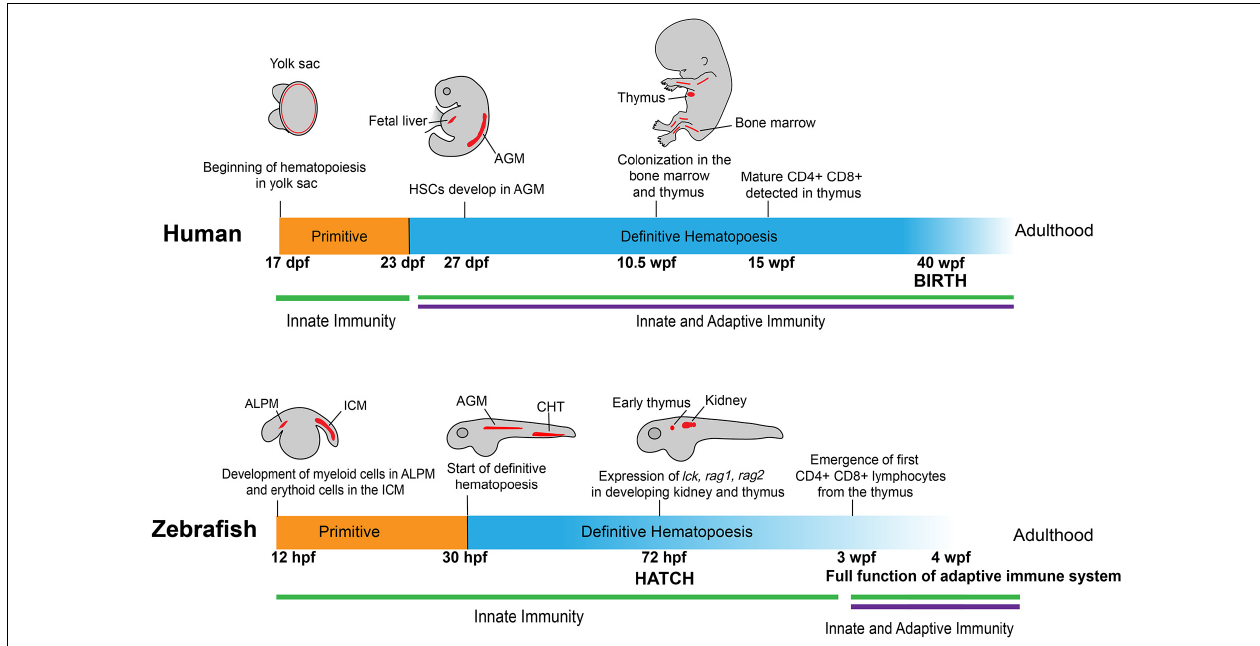
FIGURE 1 | Development of human and zebrafish immune systems. The development of the immune system starts with hematopoiesis at ∼ 17 dpf in humans and 12 hpf in the zebrafish, with myeloid and erythroid cells arising in the ALPM and ICM, respectively (Jagannathan-Bogdan and Zon, 2013). In humans, myeloerythroid progenitor cells seed in the yolk sac before HSCs appear in the AGM at 27 dpf (Julien et al., 2016), a stage mirrored in zebrafish with the start of definitive hematopoiesis at 30 hpf in the AGM and transition into the caudal hematopoietic tissue (Jagannathan-Bogdan and Zon, 2013). At 72 hpf, vital markers for early lymphoid progenitors are present in developing immune organs, such as the early thymus and kidney in zebrafish (Willett et al., 1999; Langenau et al., 2004; Trede et al., 2004). This corresponds roughly to the colonization of immune cells in the bone marrow and thymus in the human fetus at 10.5 wpf (Kissa et al., 2008). Notably, at 72 hpf the zebrafish emerges from the chorion and into contact with the outside environment without fully developed CD4 + /CD8 + lymphocytes, which appear later at 3 wpf (Lam et al., 2004). This is contrasted to humans, in which lymphocytes are detectable at 12–13 wpf, well before birth at 40 wpf (Tavian et al., 2010). ALPM: anterior lateral plate mesoderm; ICM: intermediate cell mass; HSC: Hematopoietic stem cells; AGM: